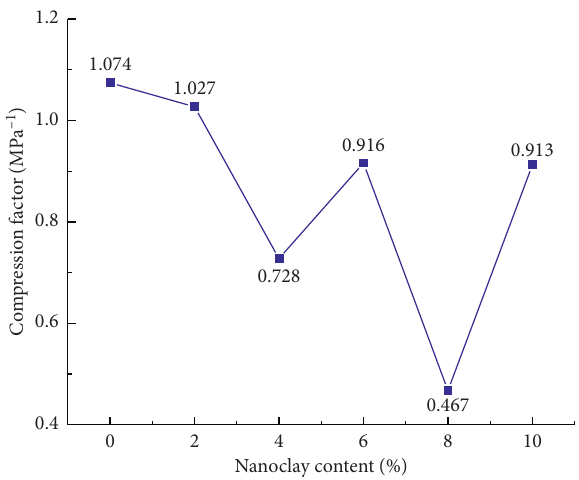
Figure 14: a 1-2 of NCS-28 of different nanoclay